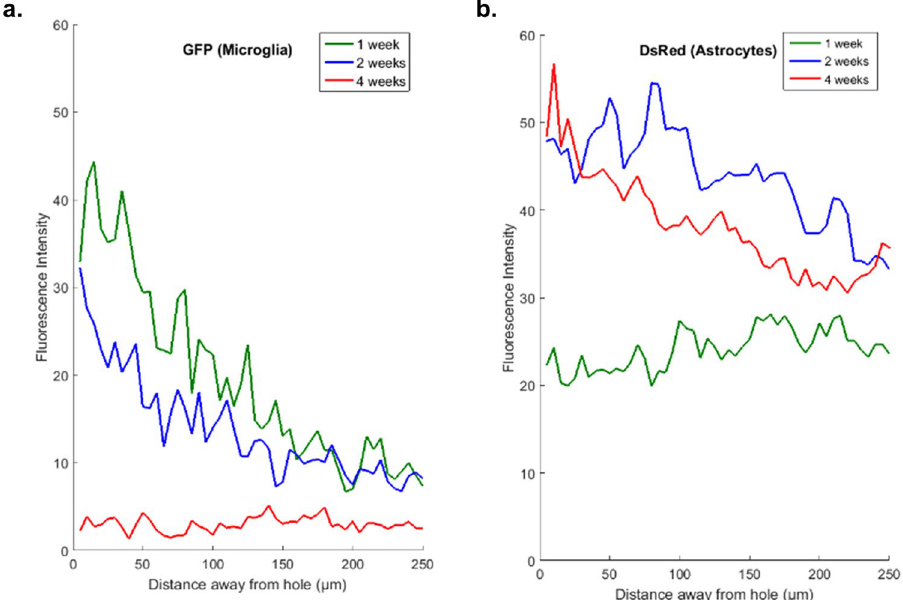
Figure 5. Fluorescence intensity profile of GFP expressing activated microglia/macrophages ( a ) and DsRed expressing astrocytes ( b ) as a function of distance (away from the ellipse drawn in Fig. 4) in PrismPlus mice implanted with “Michigan type” silicon device for 1 week (green), 2 weeks (blue) and 4 weeks (red). GFP and DsRed channels from images in Fig. 4 were used to generate the intensity profile.